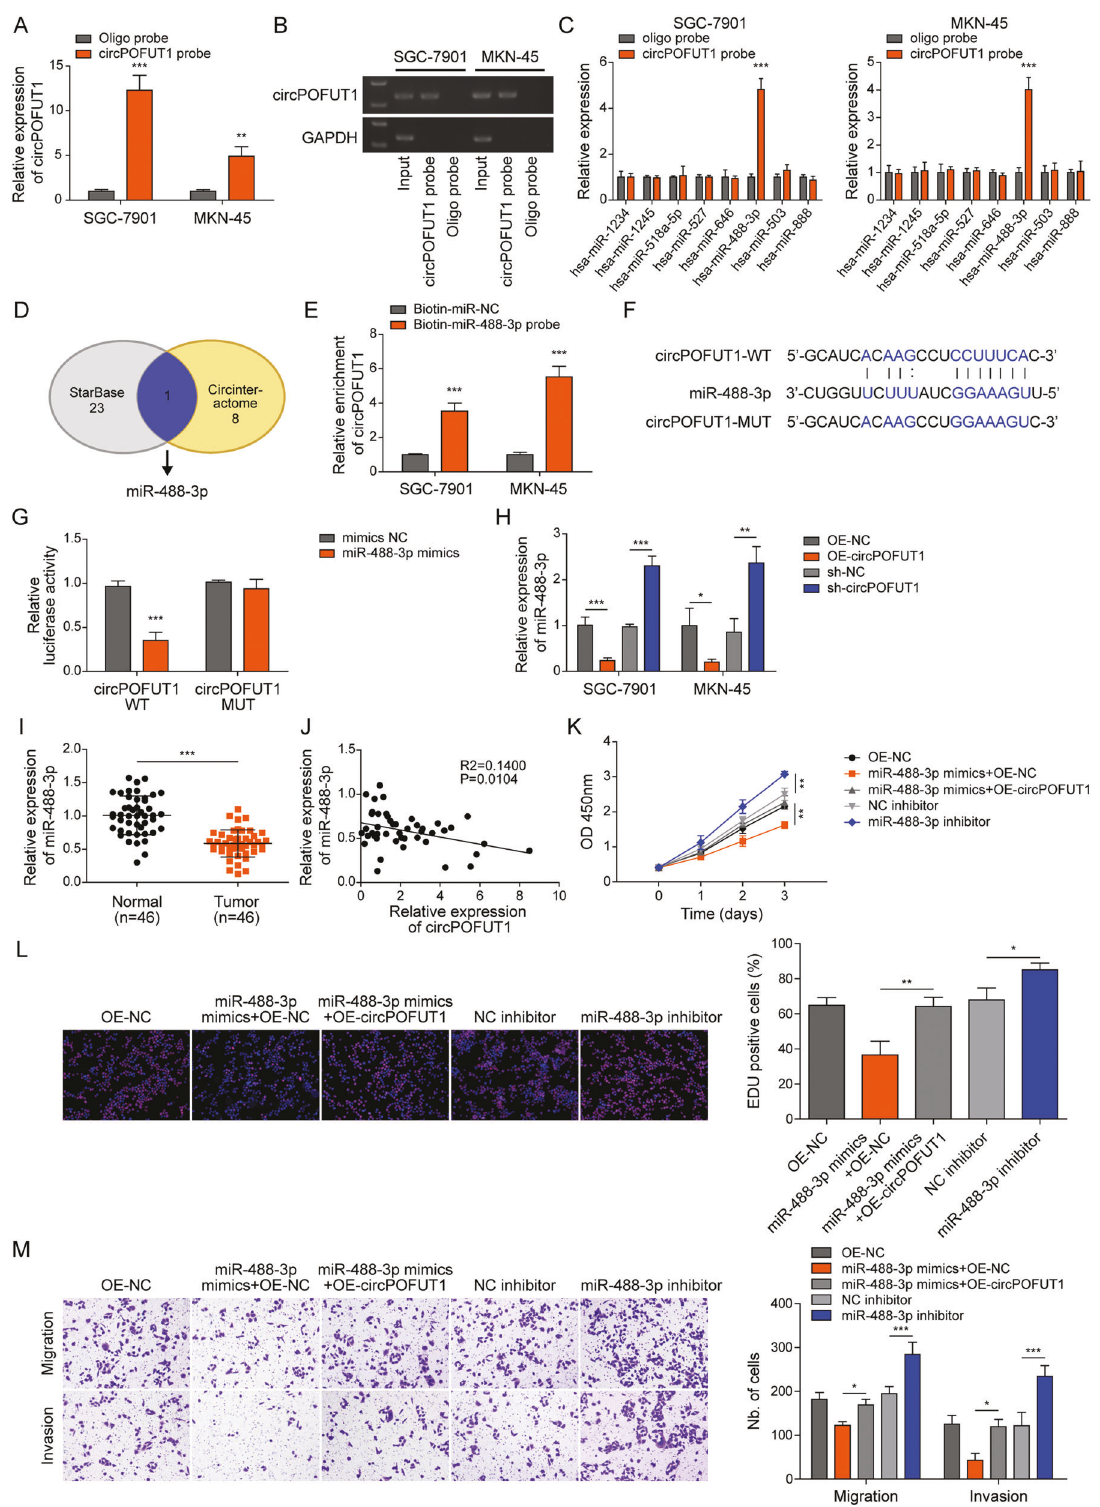
Fig. 4 CircPOFUT1 served as a sponge for miR-488-3p to promote GC malignancy. A , B CircPOFUT1 was pulled down by the circPOFUT1 probe ( n = 3). C The enrichment of hsa-miR-1234, hsa-miR-1245, hsa-miR-488-3p, hsa-miR-503, hsa-miR-518a-5p, hsa-miR-527, hsa-miR-646 and hsa-miR-888 by the circPOFUT1 probe was evaluated ( n = 3). D Downstream miRNA targets of circPOFUT1 were predicted. E CircPOFUT1 was pulled down by the miR-488-3p probe ( n = 3). F The wildtype and mutant binding sites for miR-488-3p in circPOFUT1. G The luciferase activity of wildtype (circPOFUT1-WT) and mutant (circPOFUT1-MUT) circPOFUT1 reporters ( n = 3). H RT-qPCR analysis of miR-488-3p ( n = 3). I The expression of miR-488-3p in GC and normal tissues ( n = 46). J The correlation analysis of the expression of circPOFUT1 and miR-488-3p. K Cell proliferation was evaluated by CCK-8 ( n = 3). L EdU (Red) incorporation assays ( n = 3; Nuclei, Blue). M Transwell assays for migration and invasion ( n = 3). * P < 0.05, ** P < 0.01 and *** P < 0.001. Cell Death and Disease (2023)